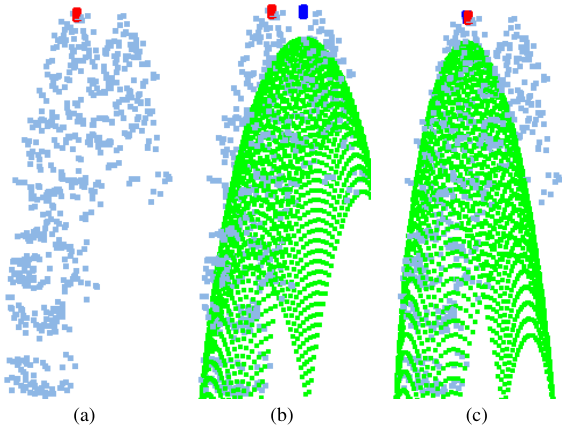
Figure 5. (a) Undersegmented point cluster with two peaks, reference position marked in red. (b) Best paraboloid fit without position prior, center marked in blue. (c) Best paraboloid fit with position prior, δ = 10